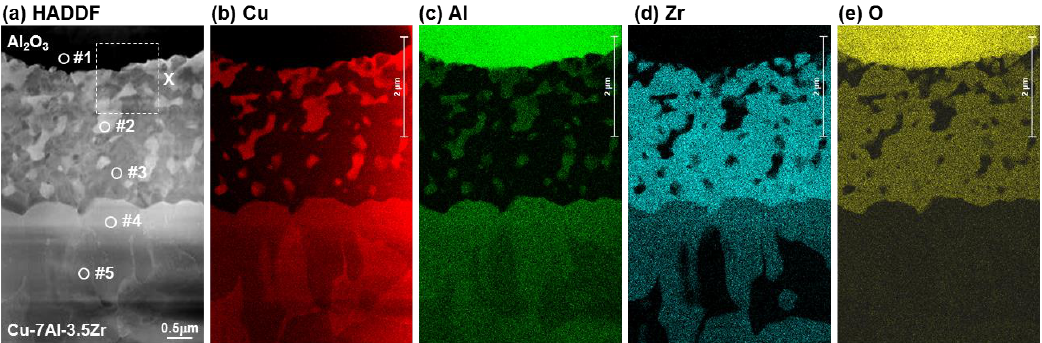
Figure 7. ( a ) High-angle annular dark-field (HAADF) image of area X in Figure 6, and ( b – e ) elemental mapping for Cu, Al, Zr, and O, respectively.